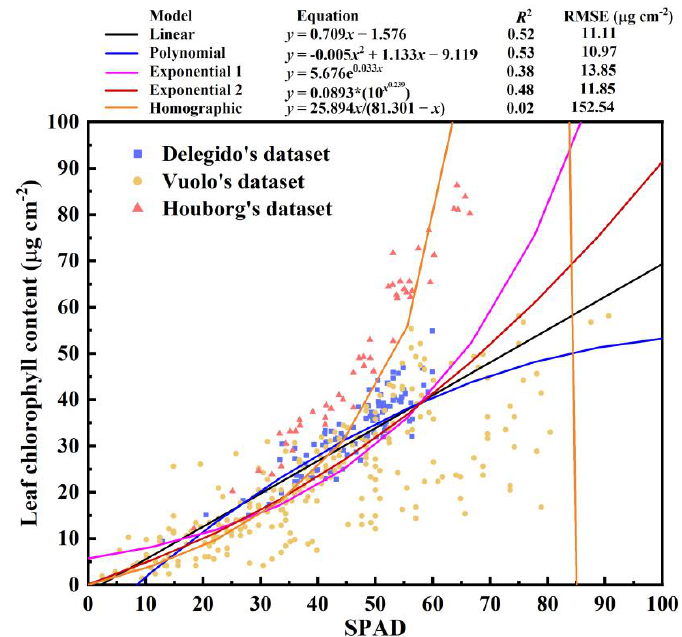
Figure 1. The assessment of five functions (i.e., linear, polynomial, exponential 1, exponential 2, and homographic models) for the estimation of the LCC using all three field datasets together. Blue squares, pale-yellow dots, and red triangles represent Delegido’s, Vuolo’s, and Houborg’s datasets, respectively. Exponential 1 is the exponential function LCC = 𝑎 ∗ 𝑒 𝑏∗SPAD , and Exponential 2 is the exponential function LCC = 0.0893 ∗ (10 SPAD 𝛼 ) . Note that the part of the homographic fitting curve is not shown because its value goes from incremental to negative infinity as the denominator of the function progressively approaches zero.